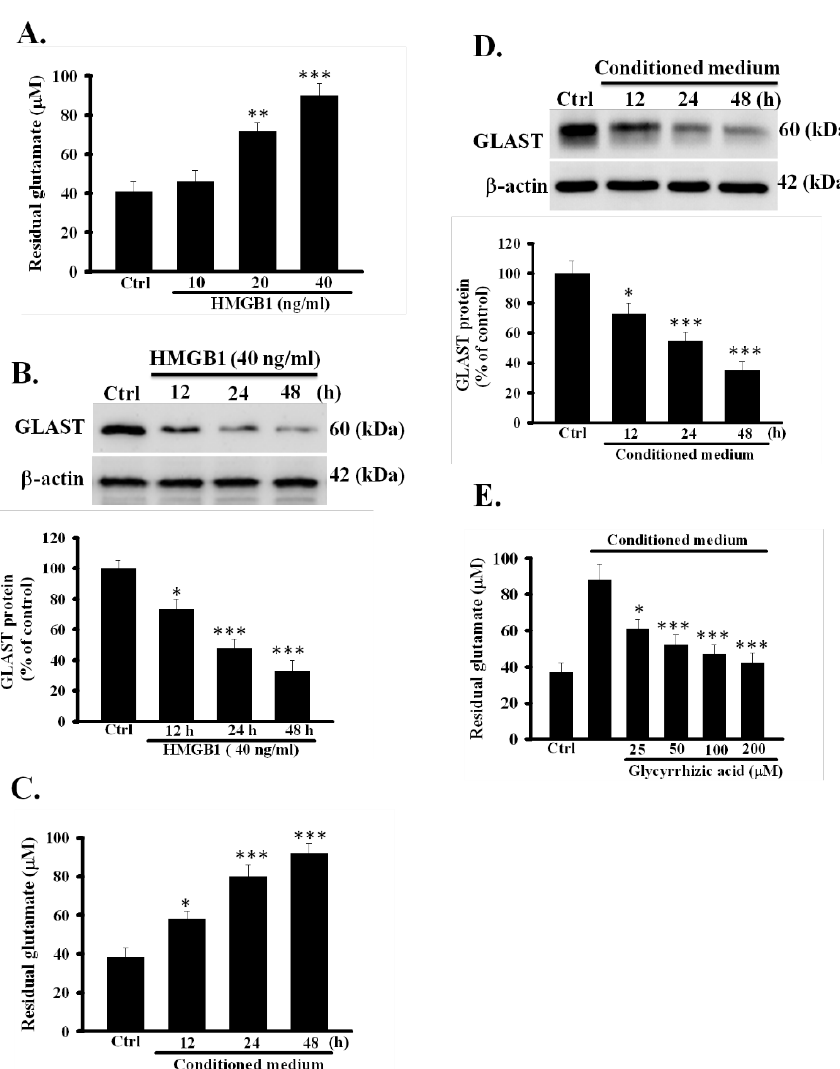
Figure 3. E ff ects of exogeneous recombinant HMGB1 and CM on function of glutamate clearance in primary astrocytes. ( A ) primary astrocytes were treated with rHMGB1 10–40 ng / mL, and the activity of glutamate clearance was assayed 24 h later. ( B ) primary astrocytes were incubated with 4 ng / mL rHMGB1 for 24 h, and GLAST protein was examined using Western blotting. ( C ) CM was collected from OGD / R-treated astrocytic culture and transferred to primary astrocytes to incubate for 12–48 h. Thereafter, the activity of glutamate clearance was assayed at each indicated time point. ( D ) Expression of GLAST protein in CM-treated astrocytes was assayed at each indicated time point by Western blotting. ( E ) Primary astrocytes were exposed to CM with or without glycyrrhizic acid (25–200 µ M) and the activity of astrocytic glutamate clearance was assayed 24 h later. * p < 0.05, ** p < 0.01, *** p < 0.001 vs. control group (ctrl). Data are presented as mean ± SEM, n = 6–8. OGD / R, oxygen-glucose deprivation / reoxygenation; rHMGB1, recombinant high-mobility group box 1; GLAST, glutamate aspartate transporter; CM, conditioned medium; n , number of repeated